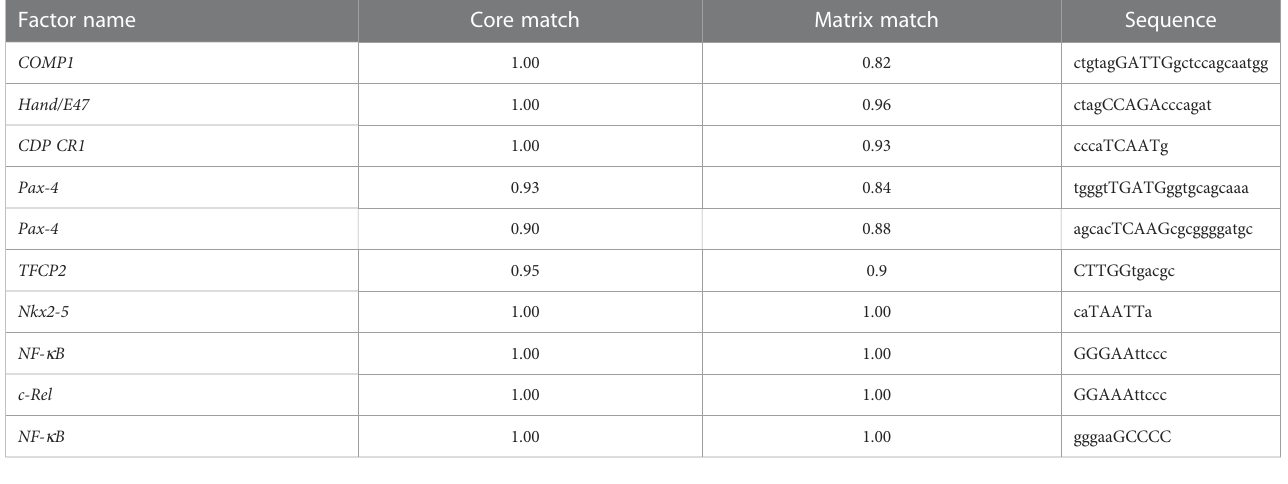
TABLE 1 The potential binding transcription factors of the CD55 .